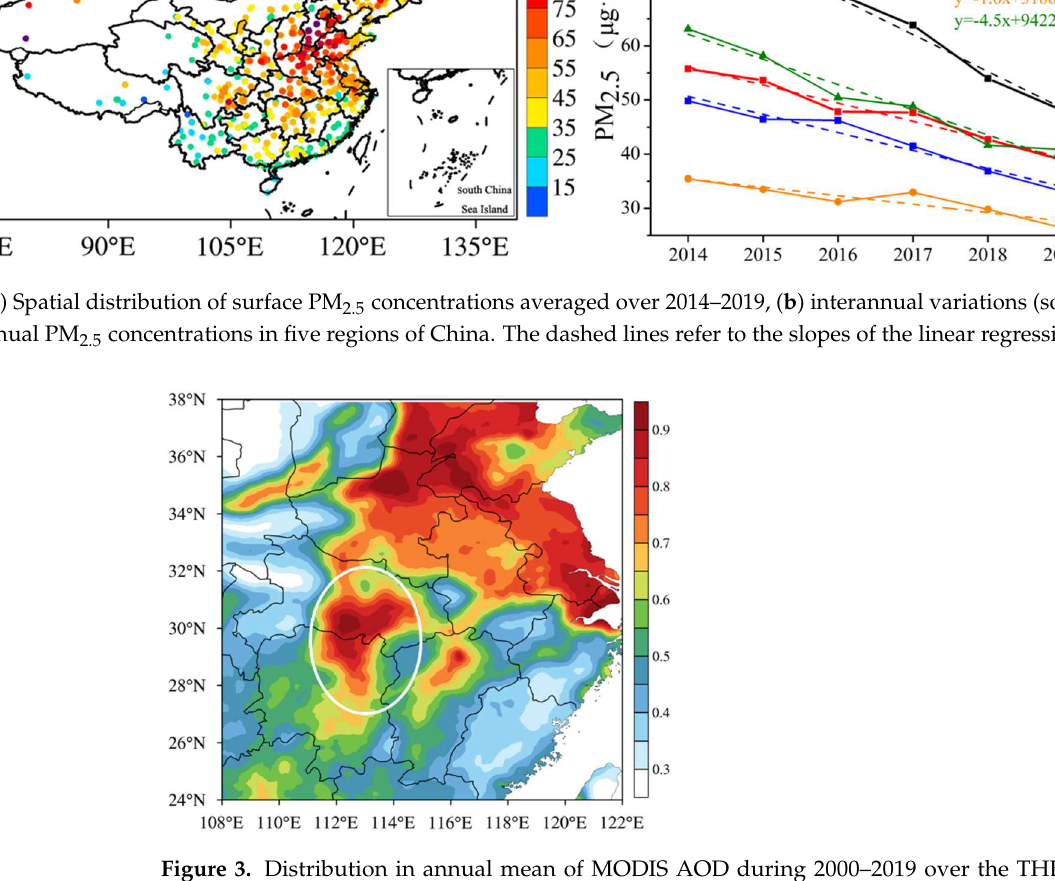
Figure 3. Distribution in annual mean of MODIS AOD during 2000–2019 over the THB and its surroundings in CEC. The oval indicates the THB region.